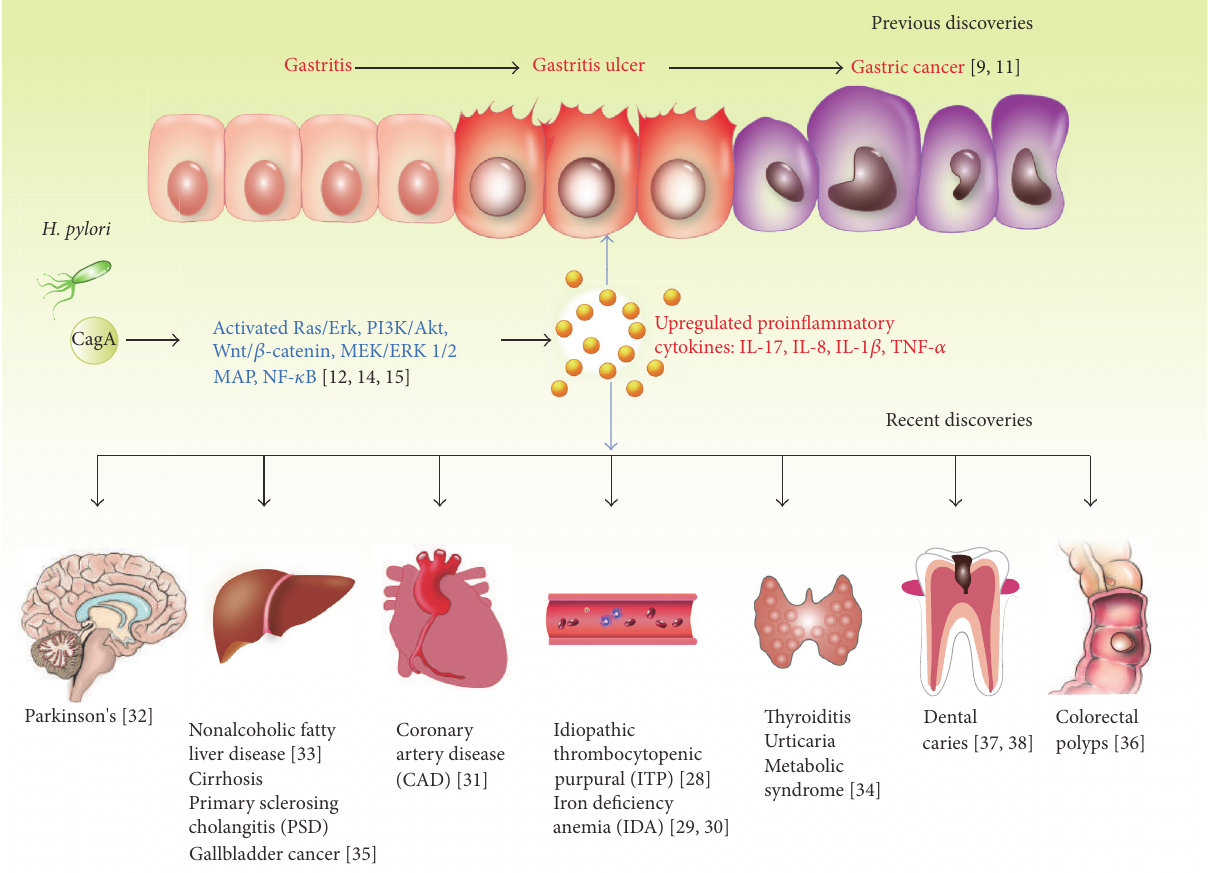
Figure 1: CagA-positive H. pylori strains-related diseases. According to previous research findings, infection with CagA - positive H. pylori strains is widely known as a higher risk of peptic ulcers and gastric adenocarcinoma. However, recent discoveries have shown that H. pylori is associated with some extragastric diseases, including cardiovascular, neurological, hematologic, metabolic, and dermatologic disorders. Inflammatory response and multiple signaling pathways might participate in mediating pathophysiological